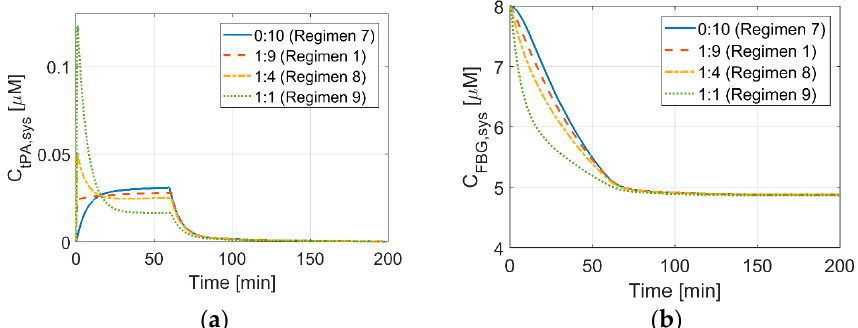
Figure 6. Effects of bolus to infusion ratios at a fixed dose of 0.9 mg/kg, on the concentration of ( a ) tPA, and ( b ) FBG. The amount of bolus is varied from 0% (Regimen 7) to 50% (Regimen 9) of the total dose. Regimen 1 has a bolus to infusion ratio of 1:9, while Regimens 8 and 9 have a ratio of 1:4 and 1:1, respectively.